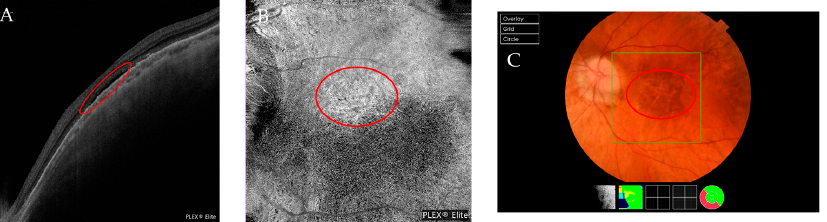
Figure 9. Multimodal images of a DSM. ( A ) In an OCT scan, the red circle indicates the presence of subretinal fluid. ( B ) In an en-face image, the red circle indicates a hyperreflective area correlated with the subretinal fluid. ( C ) In a retinography image, the red circle indicates the area where subretinal fluid is present.